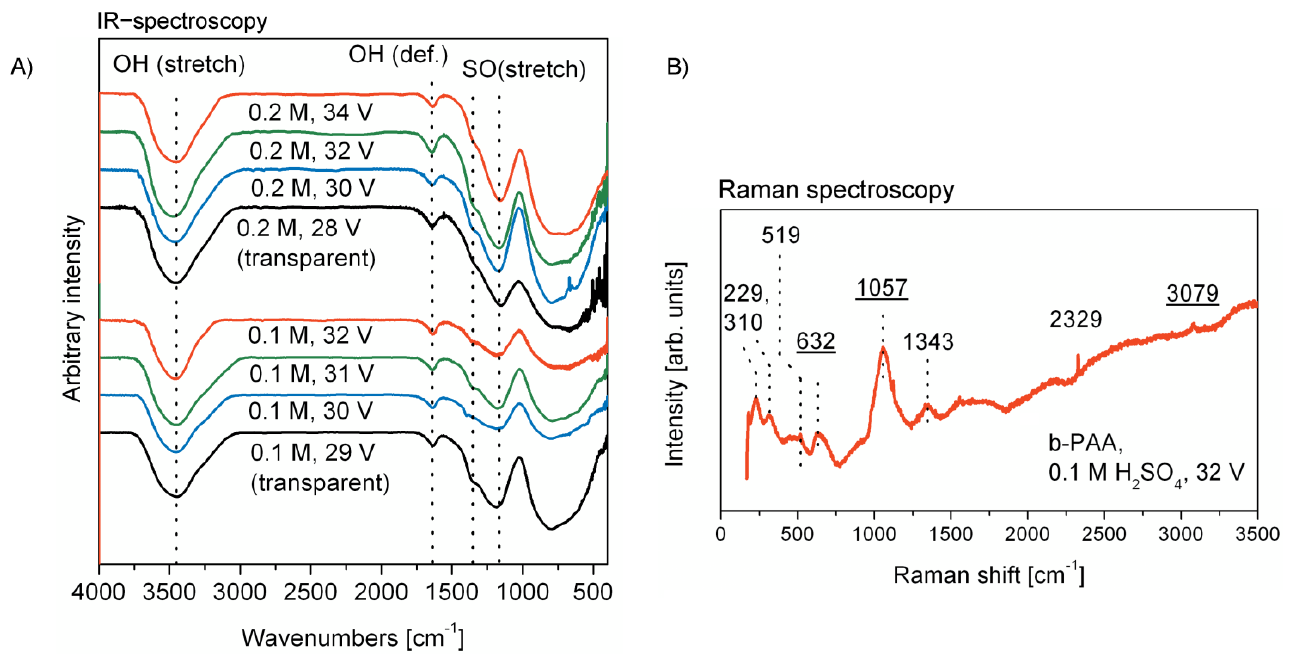
Figure 4. Summary on the vibrational spectroscopy data obtained for PAA and b-PAA synthesized in this work (all specimens are detached from substrates). Left, ( A ): comparison of the infrared (IR) spectra for translucent PAA (obtained at 28 and 29 V) and opaque b-PAA (30 – 34 V) layers from both studied electrolytes. Right, ( B ): the typical Raman spectrum features of a representative unsupported b-PAA sample (obtained from 0.1 M H 2 SO 4 at 32 V). The underlined wavenumbers correspond to the visible Raman peaks that have been previously also reported for translucent PAA. Both the IR and Raman spectroscopy methods confirm absolute absence of carbon- or copper-related admixture which could cause the black coloration.